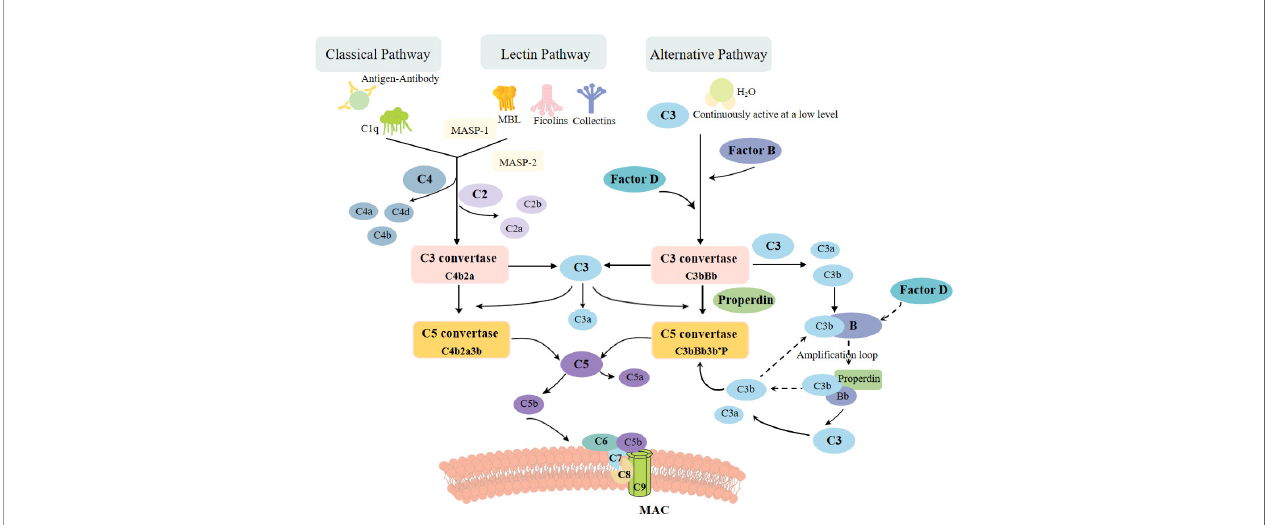
FIGURE 1 | The complement activation pathways: classical, alternative, and lectin pathway. The classic pathway is triggered by binding of antigen – antibody complexes to C1q. The lectin pathway begins with signal recognition by oligomeric structures of MBL, fi colins, and collectins, which active MASP1 and MASP2, thus in turn mediate the production of C4b. Both pathways then lead to the formation of common C3 convertase, C4b2a complex. In the alternative pathway, a small fraction of the C3 molecules is hydrolyzed, exposing new binding sites and then combined with factor B protease. After cleaved by factor D, another C3convertase (C3bBb) is formed, leading to cleavage of further C3, and this process is perpetuated through an ampli fi cation loop. All three pathways ultimately result in the cleavage of C3 and C5, leading to the formation of MAC, which inserts into membrane and then induces cell